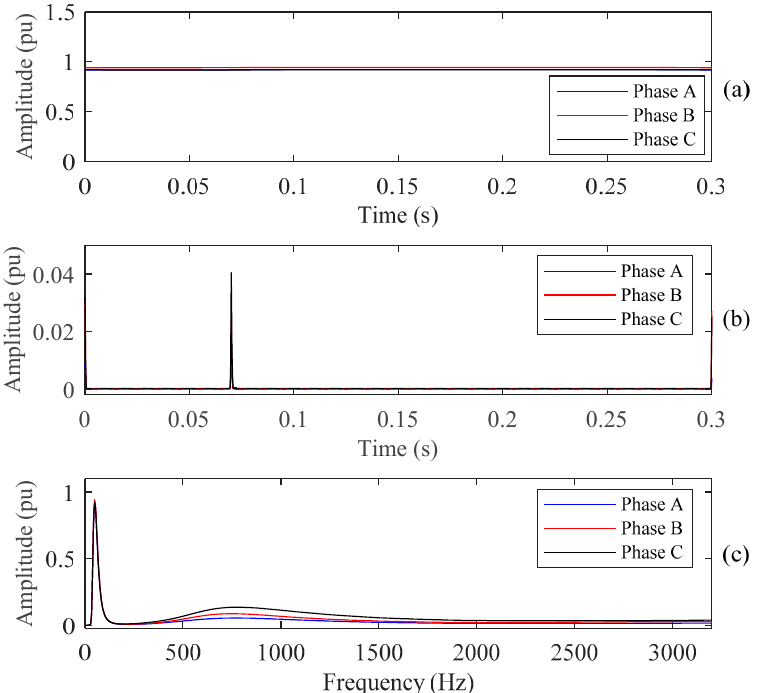
Figure 19. Related STA plots of PQ event at bus node 634 that the bank of the capacitor at bus node 675 switches on: ( a ) TvA ; ( b ) TvHFA ; ( c ) FvA.